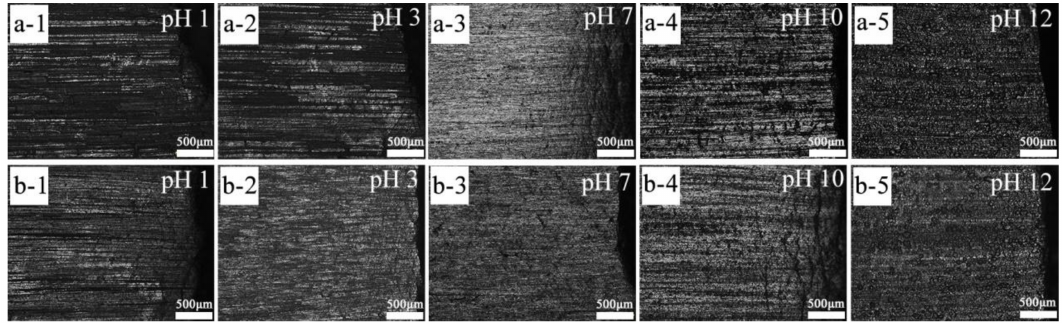
Figure 4. Surface morphologies of SSRT specimens failed at a strain rate of 5 × 10 − 6 s − 1 in 3.5% NaCl solution at different pH: ( a ) 0.00Sc; ( b ) 0.06Sc.